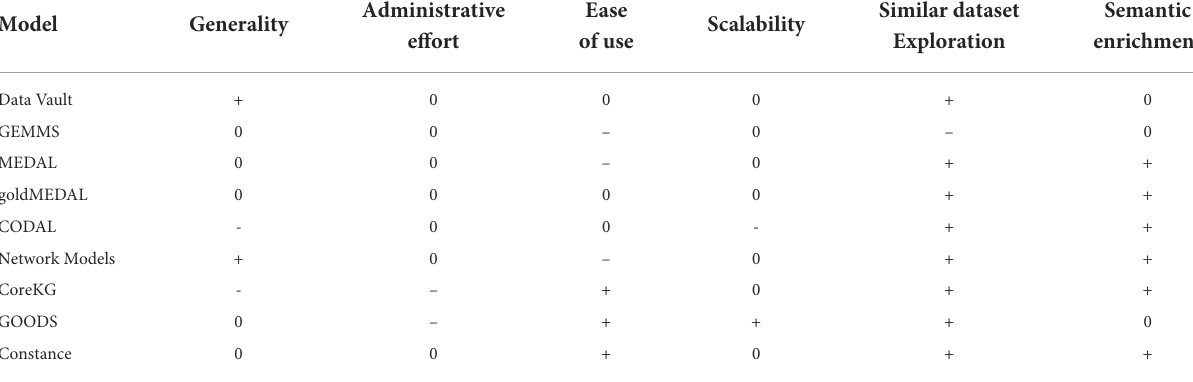
TABLE 2 Comparing the nine presented metadata models. Model Generality